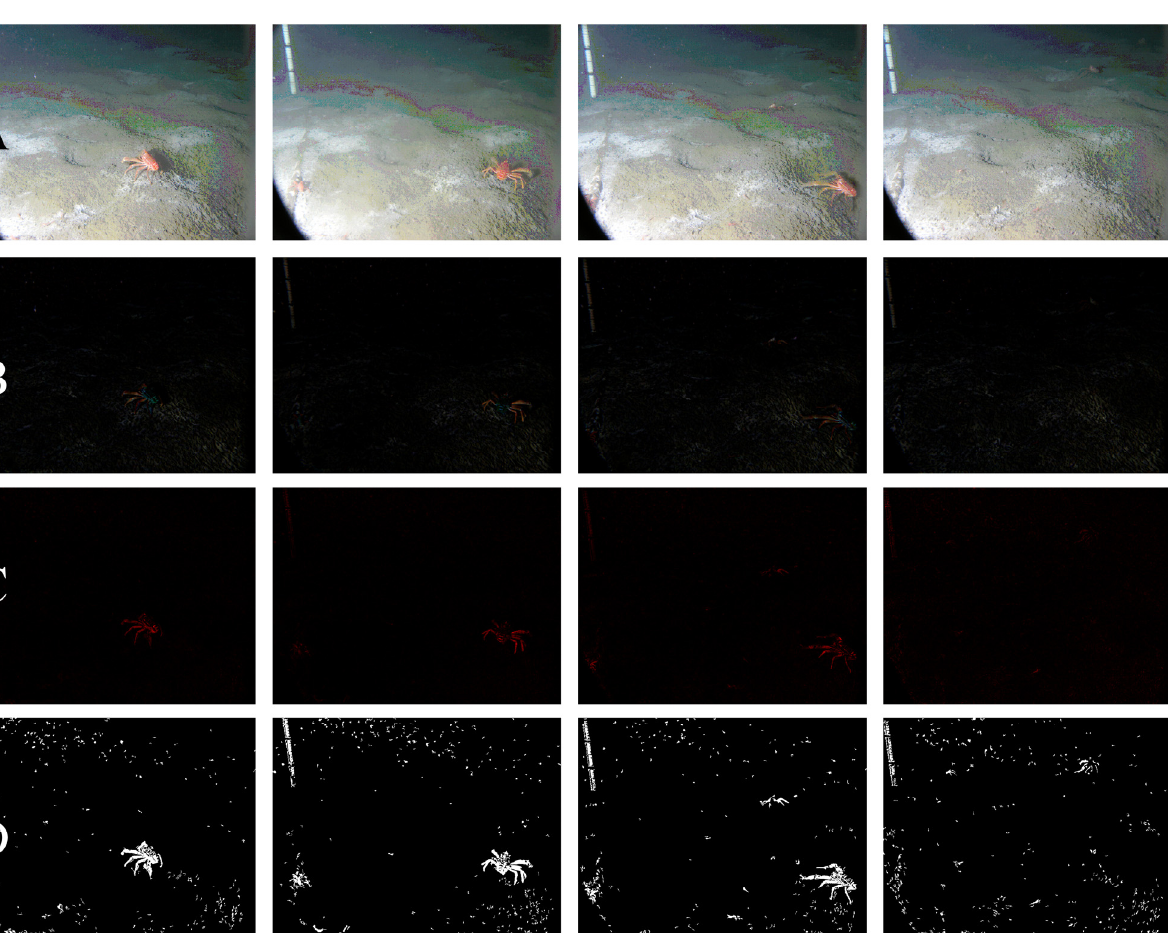
Figure 2. Example of processing of four temporally consecutive images (taken from 8:00 to 12:00 on 2 December 2009) for the automated identification and counting of the squat lobster ( Munida quadrispina ) at VENUS cabled observatory. ( A ) original RGB image, in which the metric bar appears (metric bar is on the upper left; black mark units are speared of 10 cm); ( B ) the same image after Median filtering and background correction with Top-Hat; ( C ) ED’s between R and G channel calculated for each pixel of the Top-Hat filtered-image; ( D ) segmentation using a threshold value corresponding to 95th percentile of